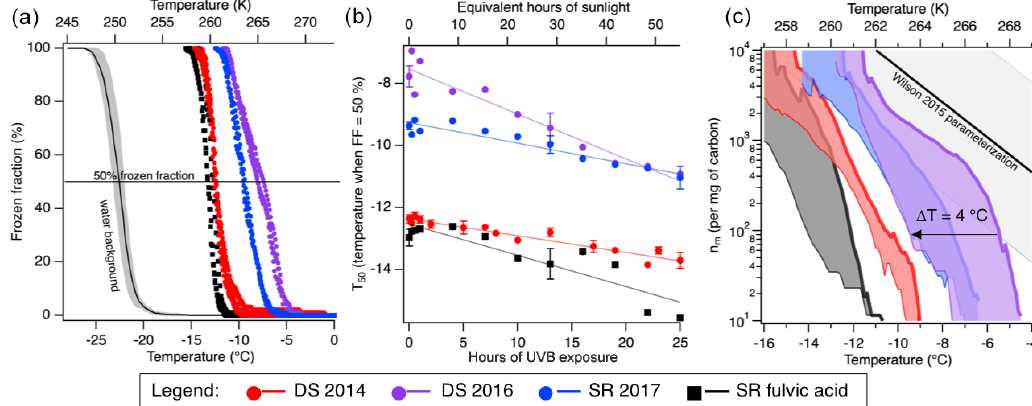
Figure 2. DOM is IN active. (a) The frozen fractions (FFs) as a function of temperature are displayed for field-collected DOM from the Great Dismal Swamp, Virginia, USA, in 2014 (DS 2014, red) and in 2016 (DS 2016, purple); from the Suwannee River, Florida, USA, in 2017 (SR 2017, blue); and for the reference material Suwannee River fulvic acid (SR fulvic acid, black). The solid 50% frozen fraction line is used to determine the T 50 , the temperature at which 50% of the droplets are frozen. Specifically, DS 2014, DS 2016, SR 2017 and SRFA showed T 50 values of − 12 . 4 ± 0 . 1, − 7 . 8 ± 0 . 3, − 9 . 4 ± 0 . 1 and − 13 . 0 ± 0 . 3 ◦ C, respectively. The black line represents the water background FF curve with standard deviation (1 σ ) from 10 different water backgrounds run over a period of 6 months. (b) T 50 as a function of UVB exposure for all DOM samples is shown. All samples exhibit a decrease in IN activity upon 25h of UVB exposure ( ∼ 55h of sunlight in the atmosphere). The lines are linear fits to the data to quantify the slope and the rate loss of IN activity. The slopes are − 0 . 054, − 0 . 145, − 0 . 066 and − 0 . 100 for DS 2014, DS 2016, SR 2017 and SRFA, respectively. (c) The shaded regions in the n m space correspond to the extent of change in IN activity due to photochemistry from the mean values at t = 0h to t = 25h. Note that the n m values were determined by accounting for the change in organic carbon content measured by TOC analysed and depicted in Fig. 4. The Wilson 2015 parameterization for n m of INPs in the sea surface microlayer is also shown for comparison (Wilson et al.,